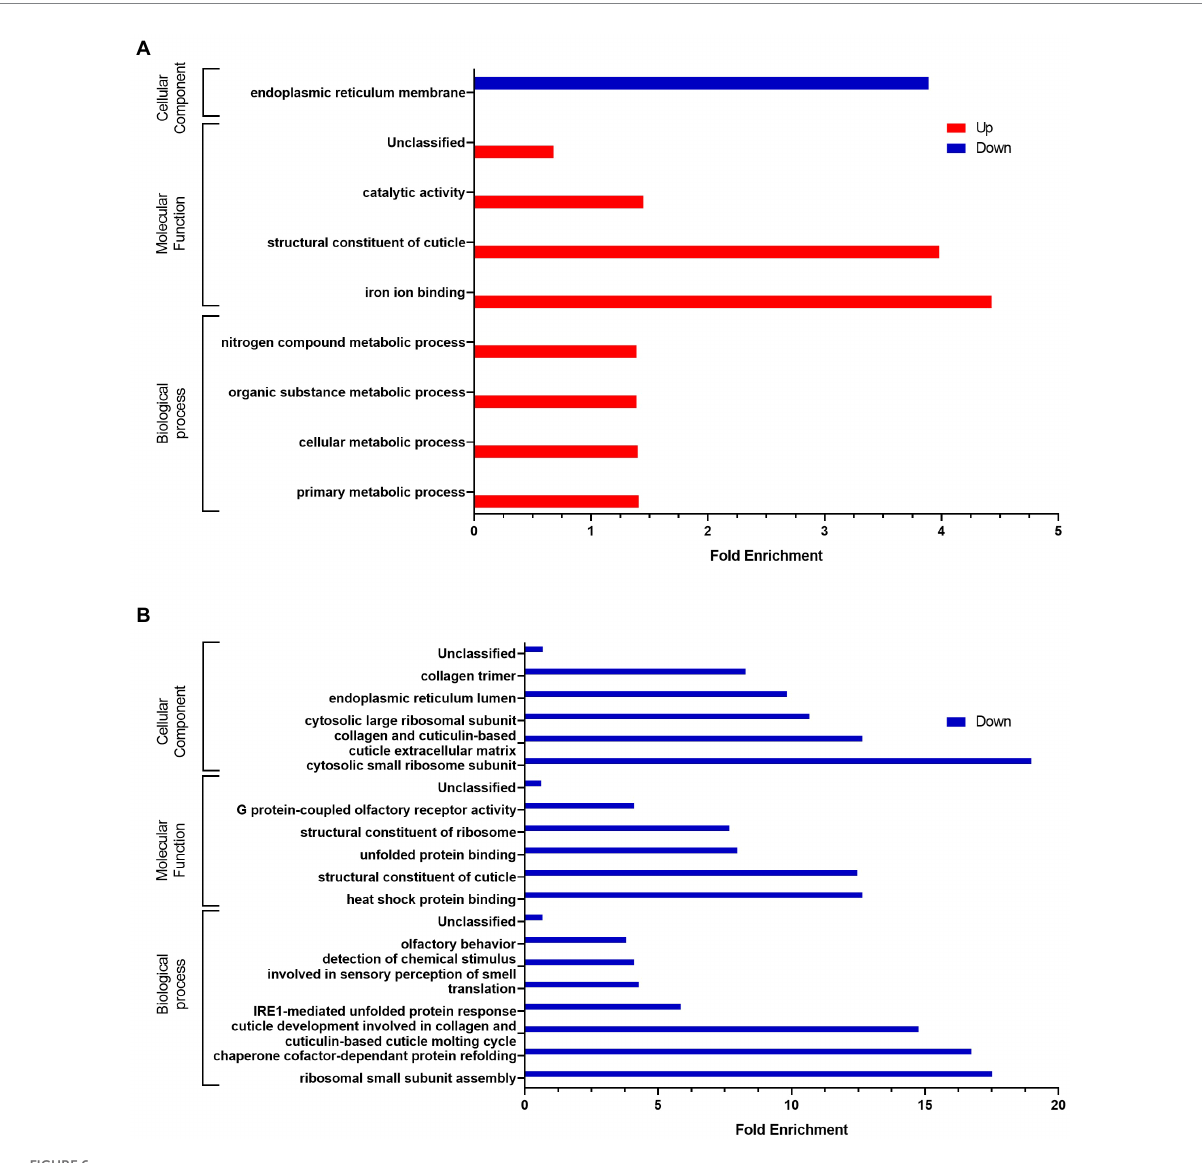
FIGURE 6 GO analyses of differentially expressed genes after (A) a L. rhamnosus Lcr35 ® preventive treatment compared to an un-treated candidiasis or (B) compared to L. rhamnosus Lcr35 ® . Only GO terms significantly enriched (value of p and false discovery rate < 0.05) are